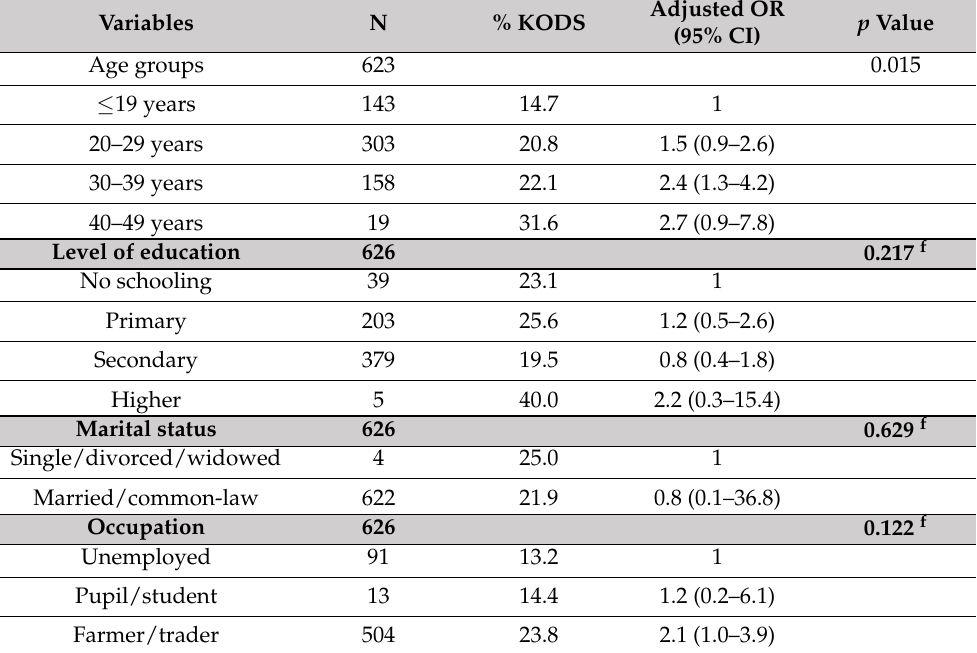
Table 5. Knowledge of ODS according to sociodemographic and clinical characteristics of respond- ents.